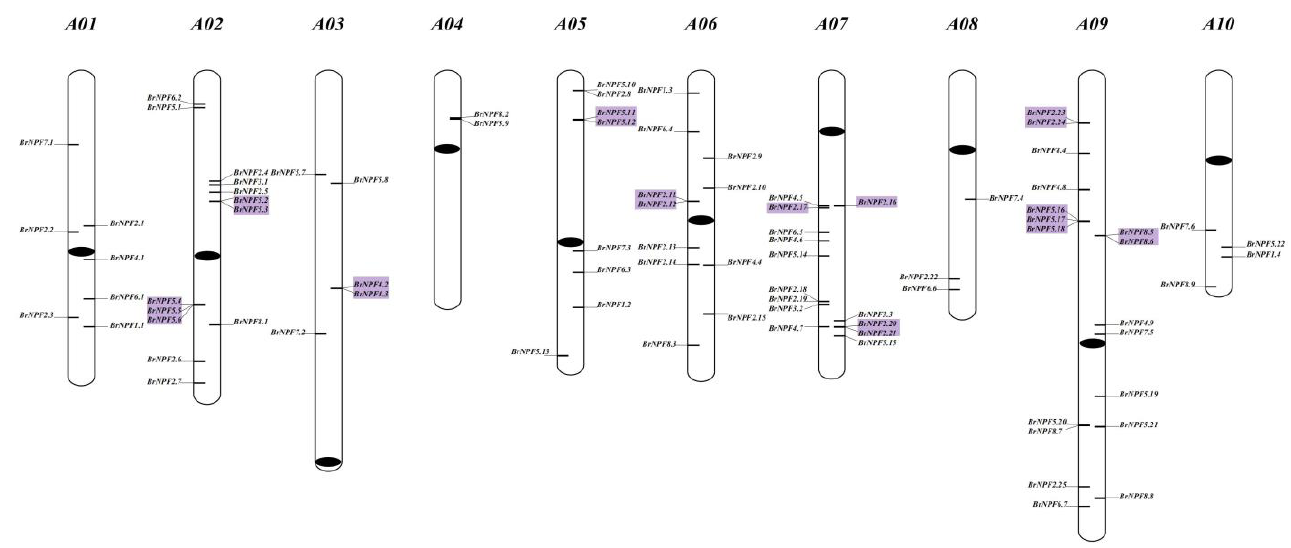
Figure A1. Chromosomal locations of BrNPFs identified in this study. The chromosomal number is indicated above each chromosome. Black ovals on each chromosome indicate centromeric regions. Tandem duplicated genes are indicated by purple rectangles.